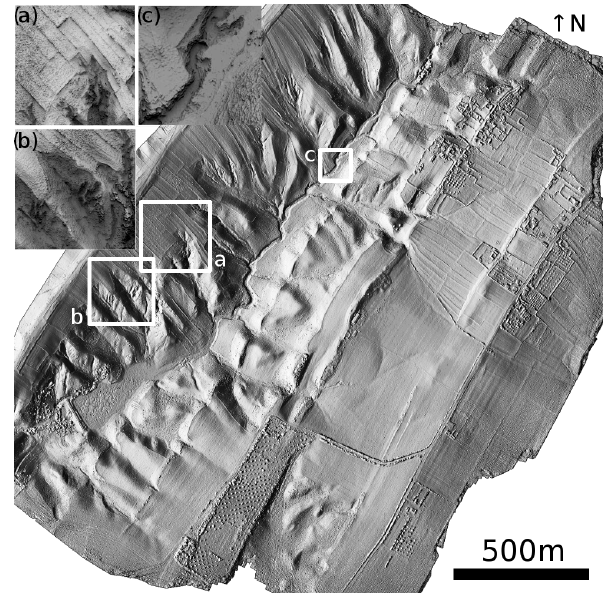
Figure 8. Shaded images of the computed DEM over the Kamech test site. The main image is a classical shading of the DEM com- puted with a unique illumination source located in the east. The three zoomed-in panels are shaded images computed as the por- tion of visible sky at each point. This latter type of shading high- lights local features such as steep slopes and areas of high curvature: (a) shows some cultivated plots with the plot borders easily visible and a gully head downstream of the plots; (b) shows a gully head; and (c) shows the main thalweg headcut, which is experiencing slow regressive erosion processes. Table 4. Error statistics of the comparison at the scale of the channel network (Fig.